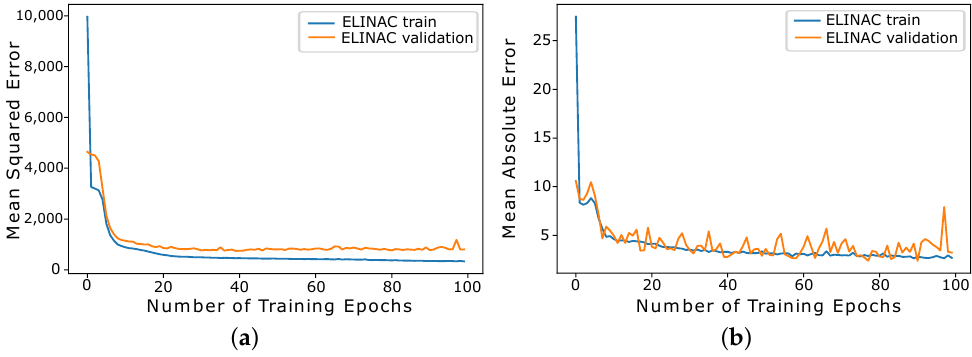
Figure 6. Evaluation of ELINAC training curves for ( a ) MSE and ( b ) MAE.